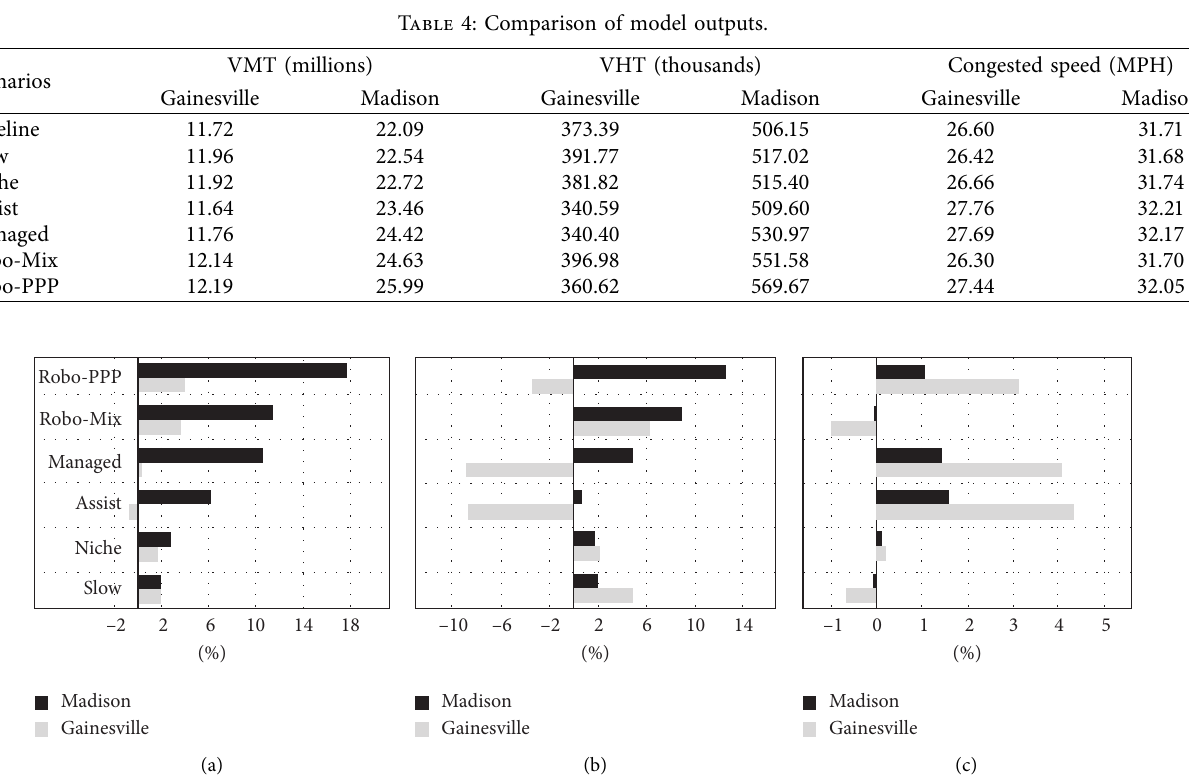
Figure 1: Proportional change of each scenario from the baseline. (a) VMT change. (b) VHT change. (c) Congested